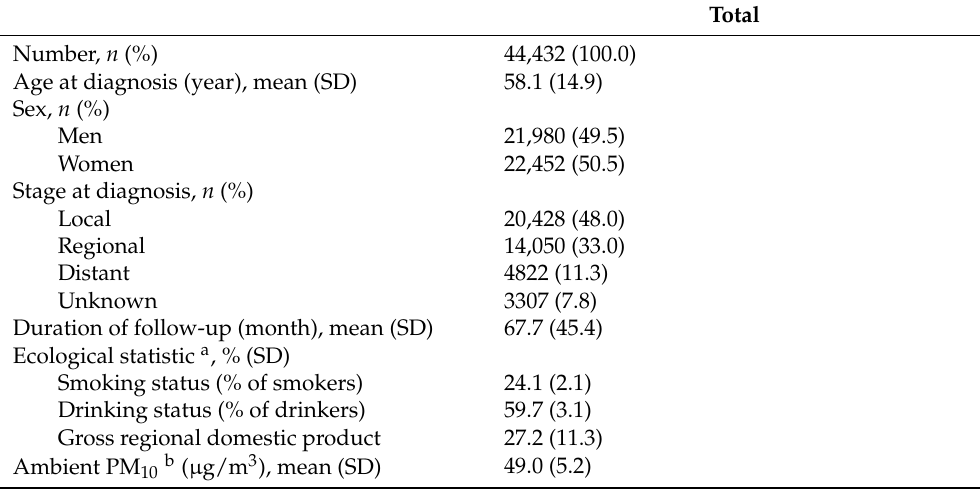
Table 1. General characteristics of the study